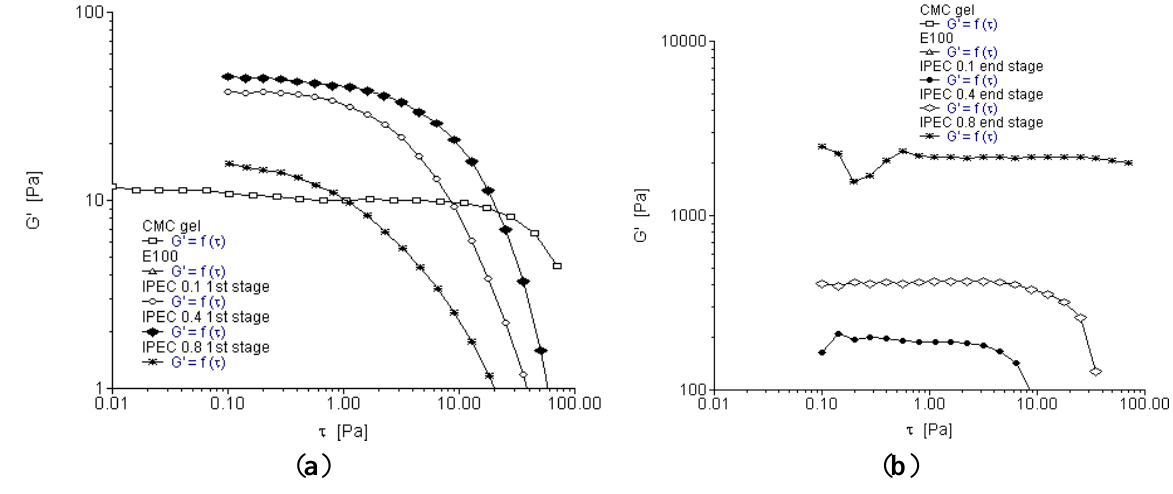
Figure 4. Elastic modulus as a function of shear stress for ( a ) the native polymers and IPEC at initial stage of synthesis at frequency of 1 Hz; ( b ) the native polymers and IPEC